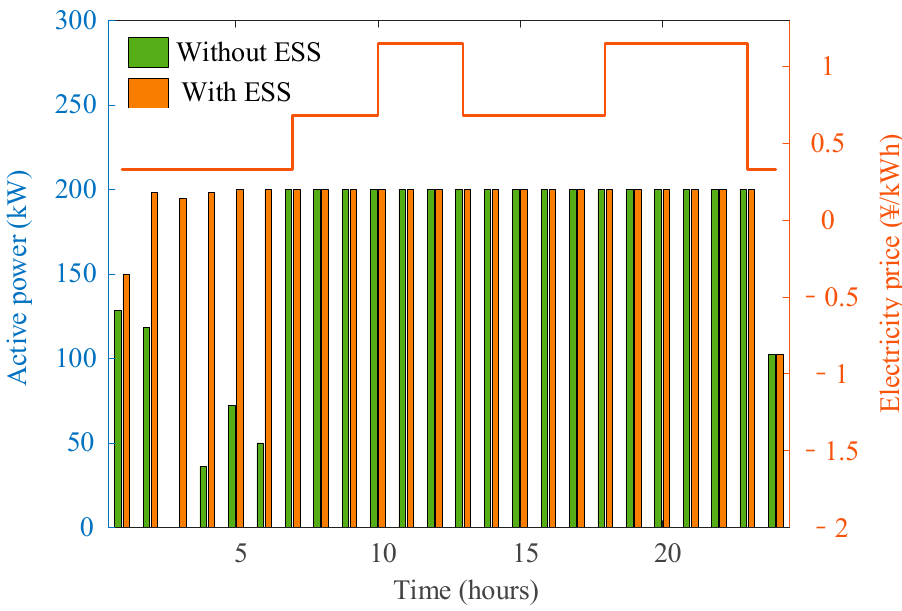
Figure 7. Output of micro turbine (MT).